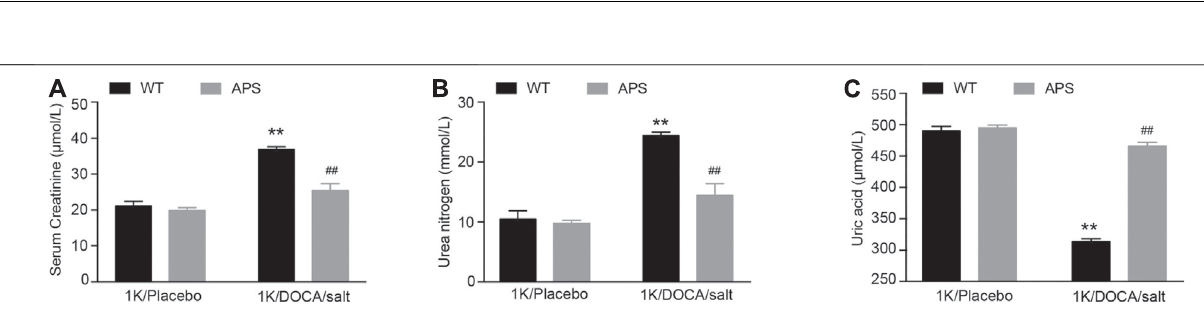
Frontiers in Pharmacology |